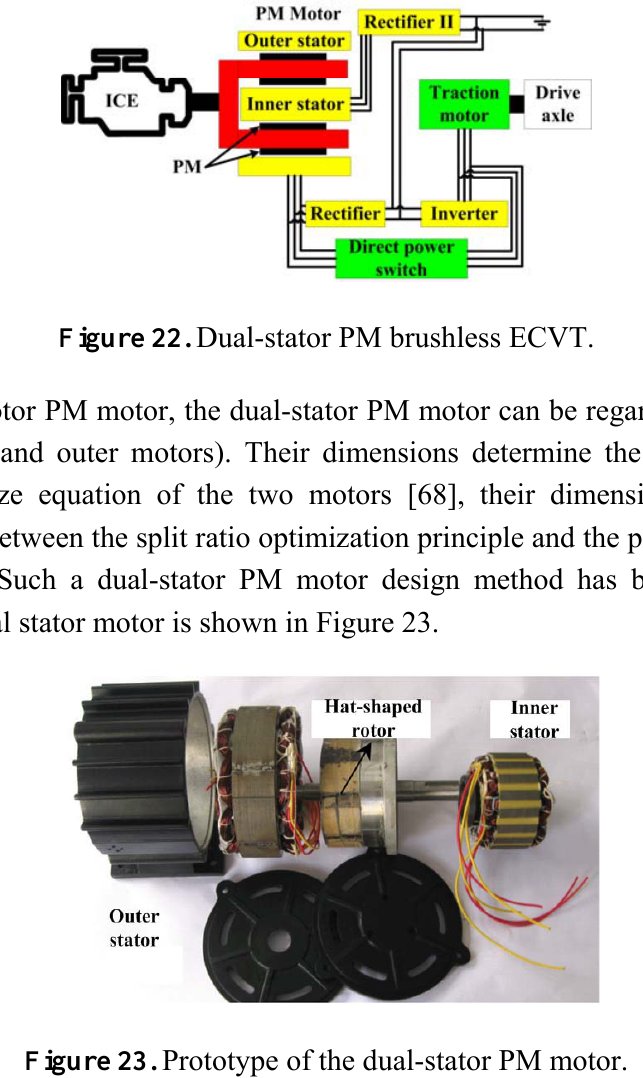
Figure 23. Prototype of the dual-stator PM